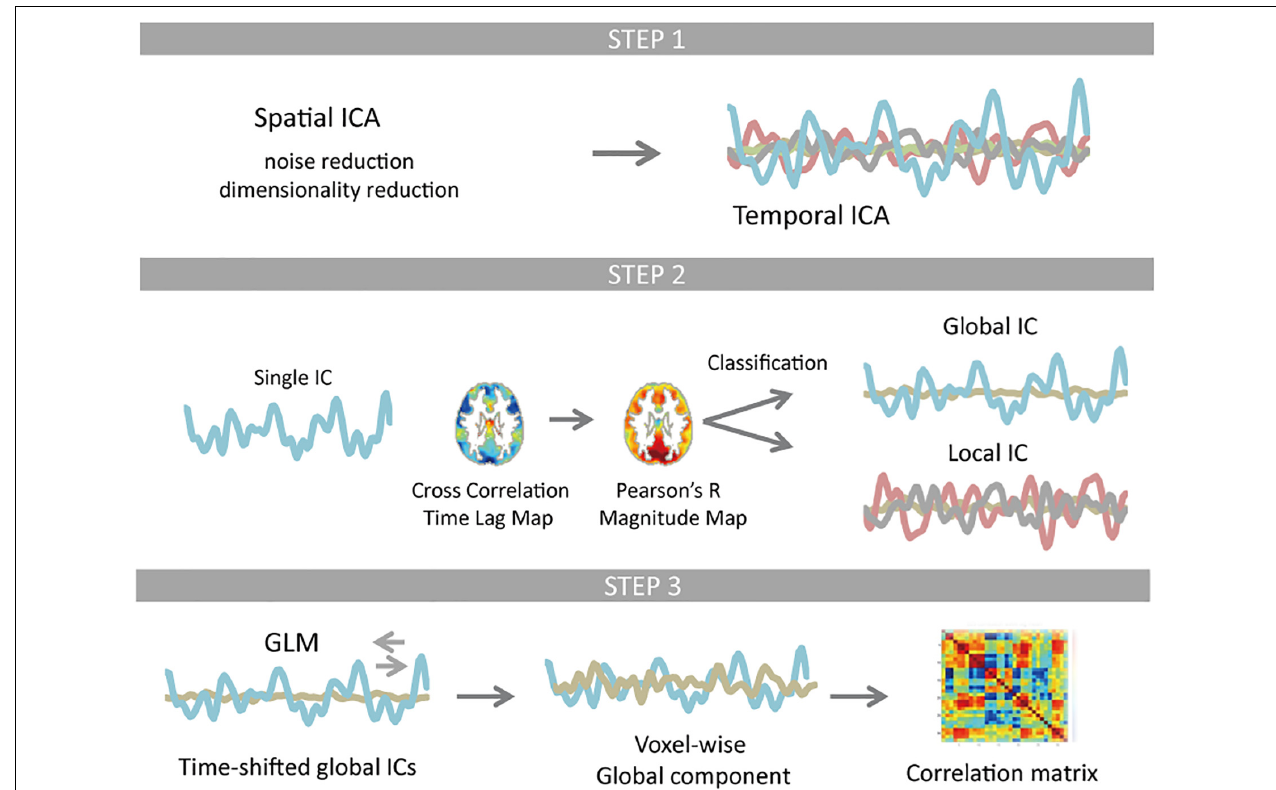
FIGURE 1 | Schematic of the resting-state fMRI data processing. Temporal independent component analysis (ICA) was applied to pre-processed test and re-test dataset, whose dimensionality were reduced to 61 × 120,000 and 62 × 120,000 using spatial ICA, respectively. Each temporal ICA gave 28 and 30 reproducible components (Step 1). For each component (IC time series), a time lag map was obtained by computing the time lag of each voxel relative to the IC time series using cross-correlation, which was further interpolated with parabolic polynomials. Pearson’s correlation coefficients were computed between each voxel’s time series and the IC time series that was shifted as much as the measured time lag. Classification of ICs was based on spatial distribution pattern of each component. Any component that is more similar to the whole-brain signal than any RSN template in distribution pattern was classified as global (Step 2). Using the time-shifted global ICs as regressors, linear regression analysis was performed for each voxel. All global ICs detected for any single temporal ICA were then integrated. The rest of the signal change was classified as local contribution. The correlation matrix of the global as well as local component was computed and compared with the correlation matrix of the original signal FC matrix (Step